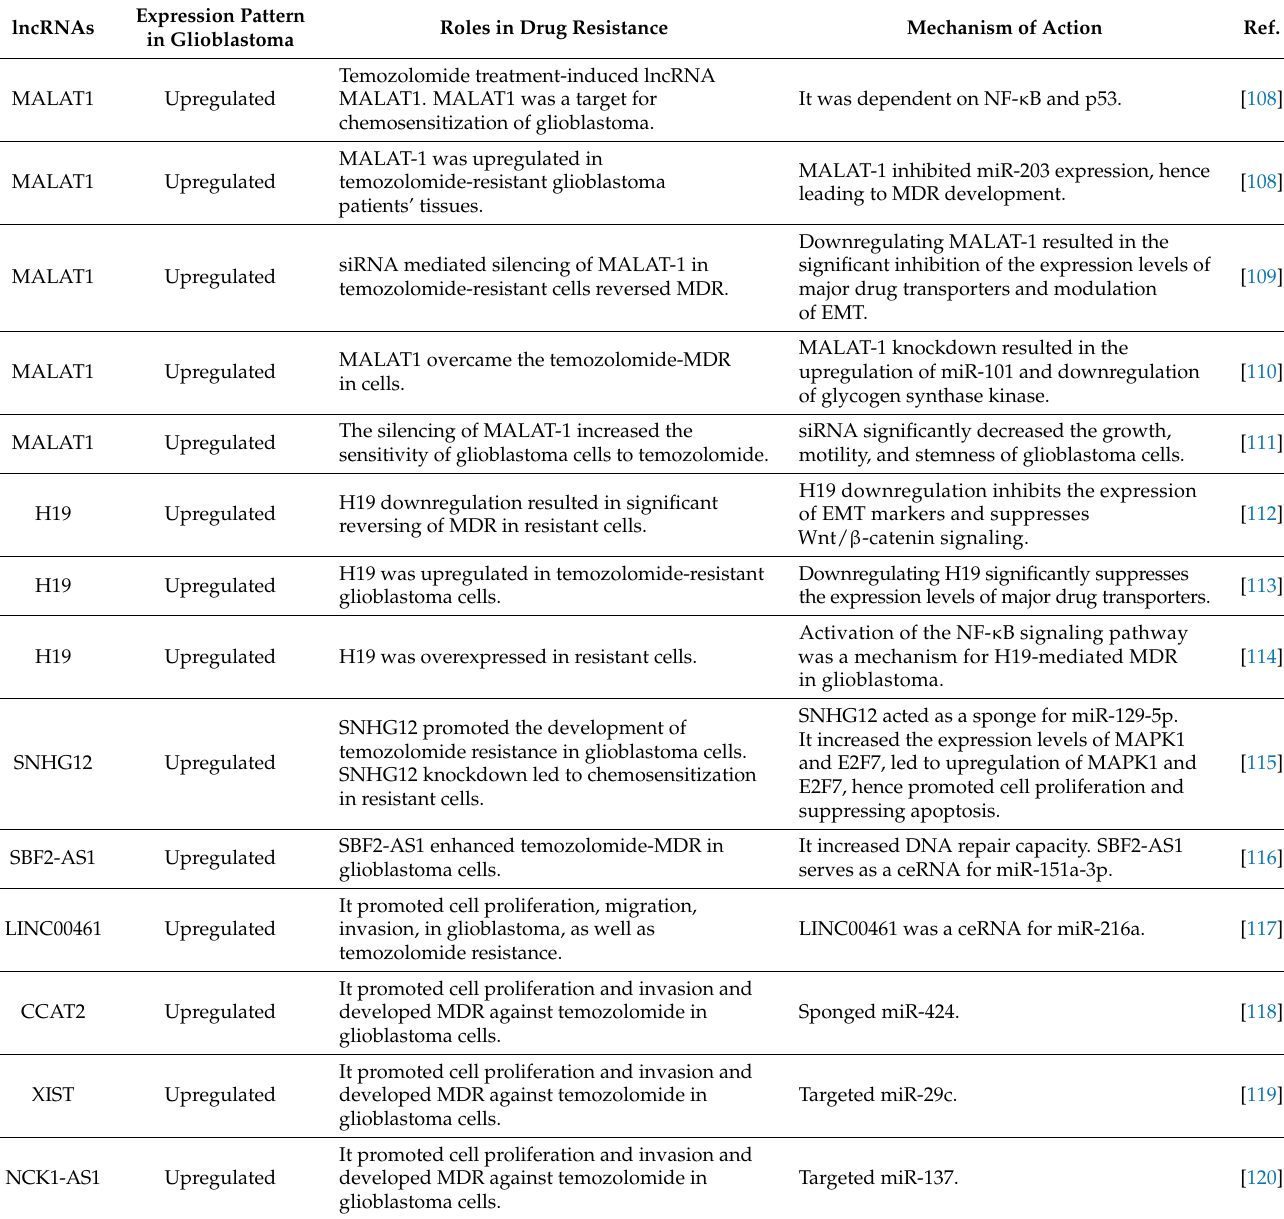
Table 2. lncRNAs in drug resistance of